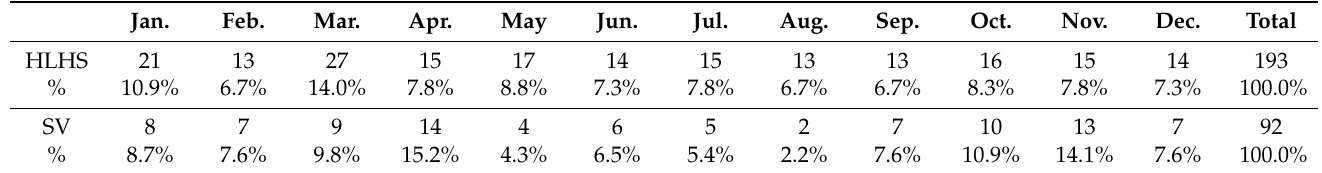
Table 2. The logistic regression model (a forward stepwise model) testing the parameter affecting HLHS (A) and SV (B) frequency.